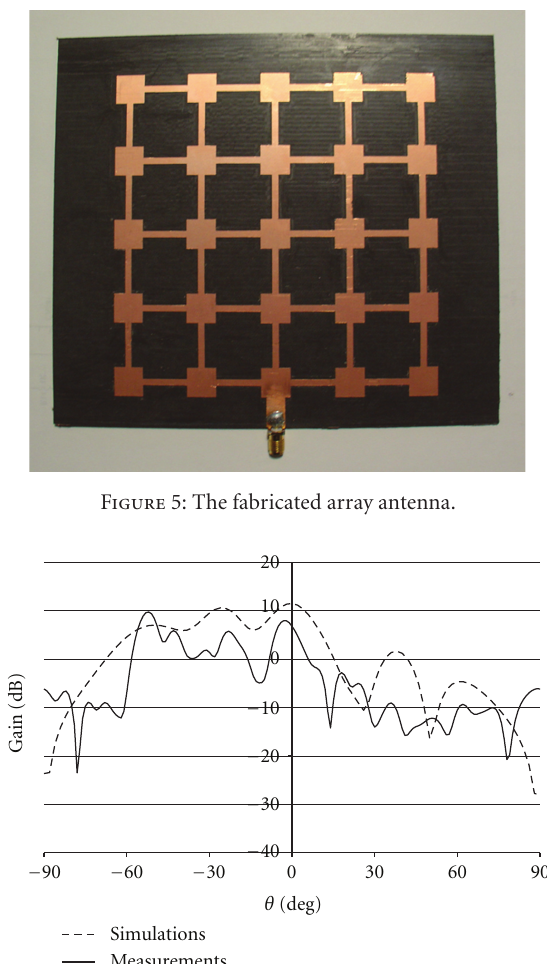
Figure 6: Radiation pattern on plane A ( ϕ = 0 ◦ , θj ( − 90 ◦ ≤ θj ≤ 90 ◦ )).